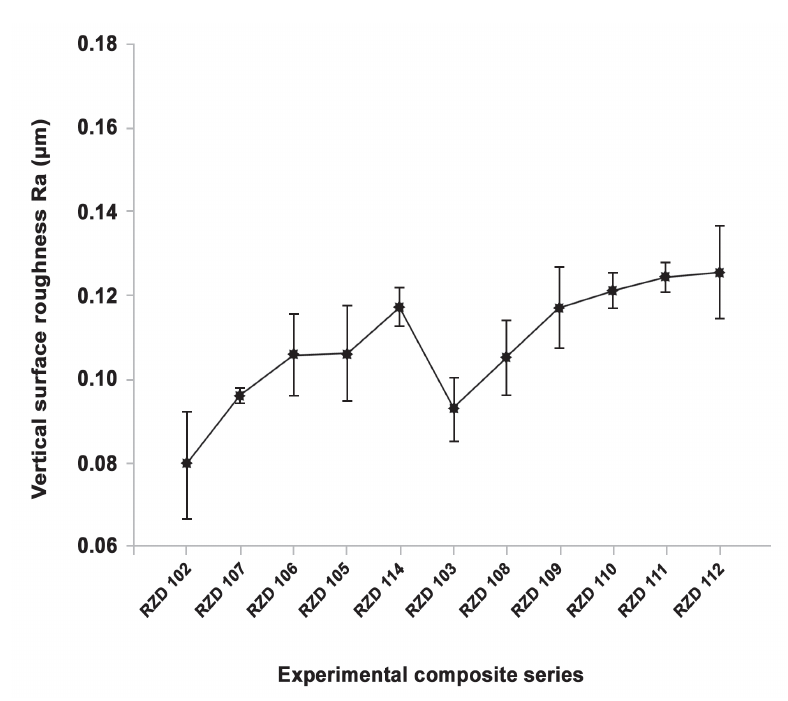
Figure 4- Vertical surface roughness, R